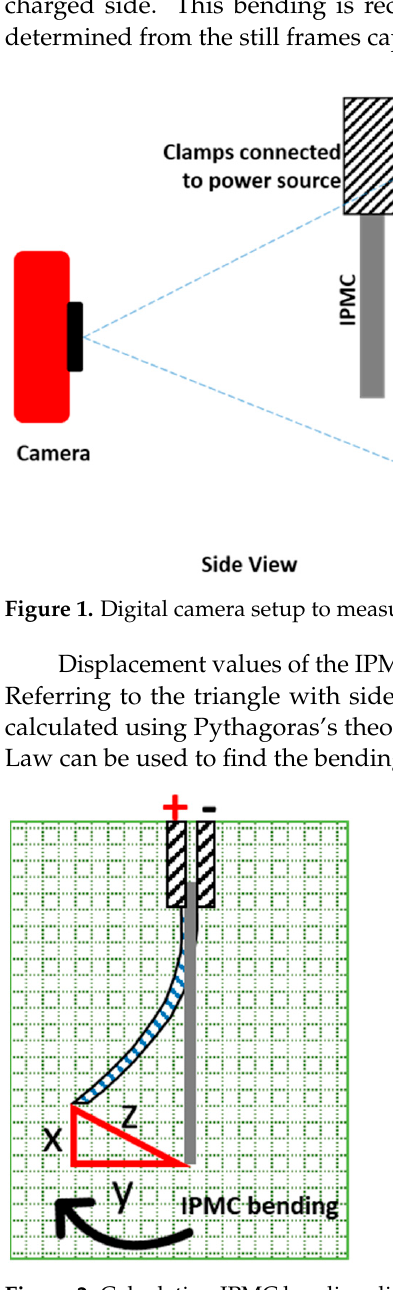
Figure 2. Calculating IPMC bending displacement.